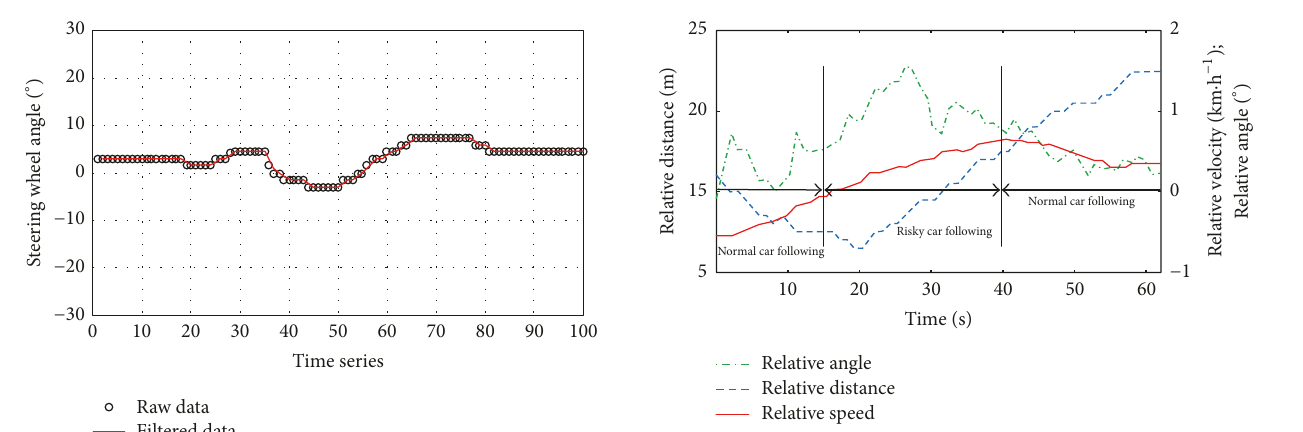
Figure 5: Steering wheel angle changes during lane departure behavior.